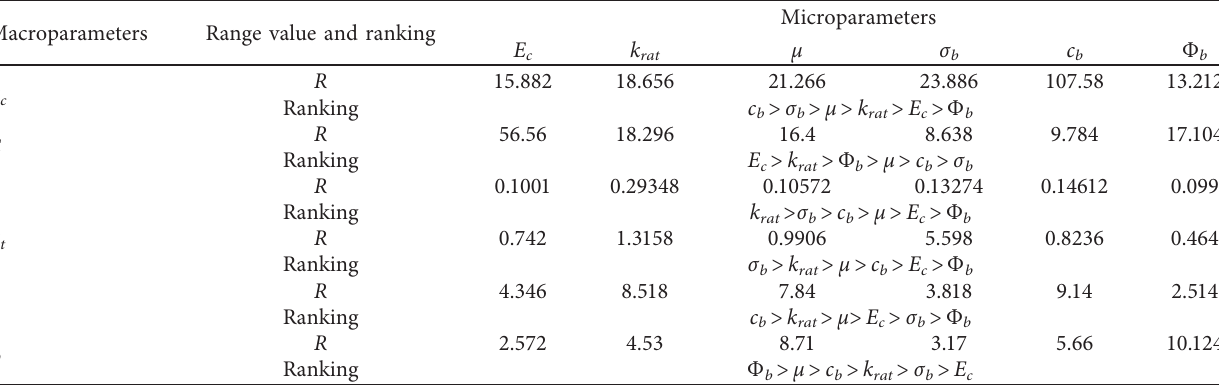
Figure 9: Numerical model for rock mechanic test: (a) uniaxial compression test; (b) triaxial compression test; (c) direct tension test. Table 6: Results of range analysis.